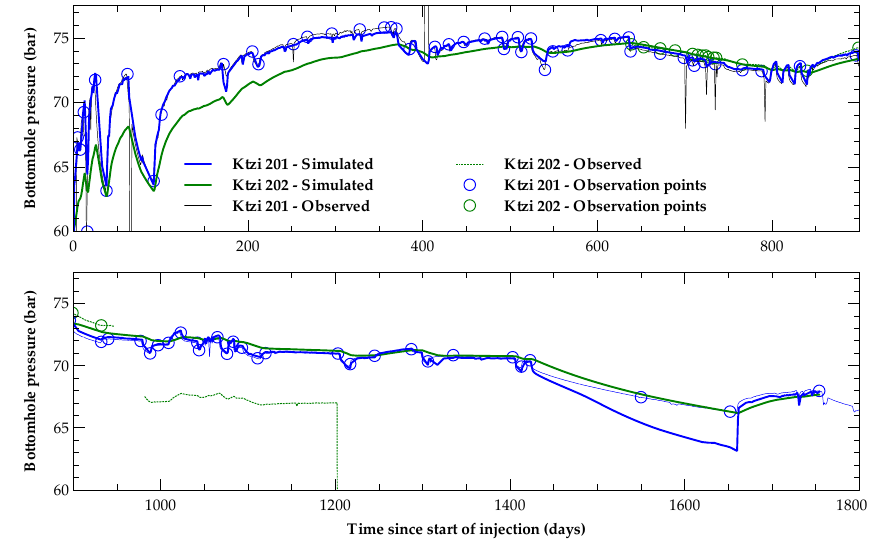
Figure 4. Comparison of observed and simulated bottomhole pressures in the injection well Ktzi 201 and the second observation well Ktzi 202 in the CO 2 injection phase. Circles indicate the observations used in the integrated inverse modelling